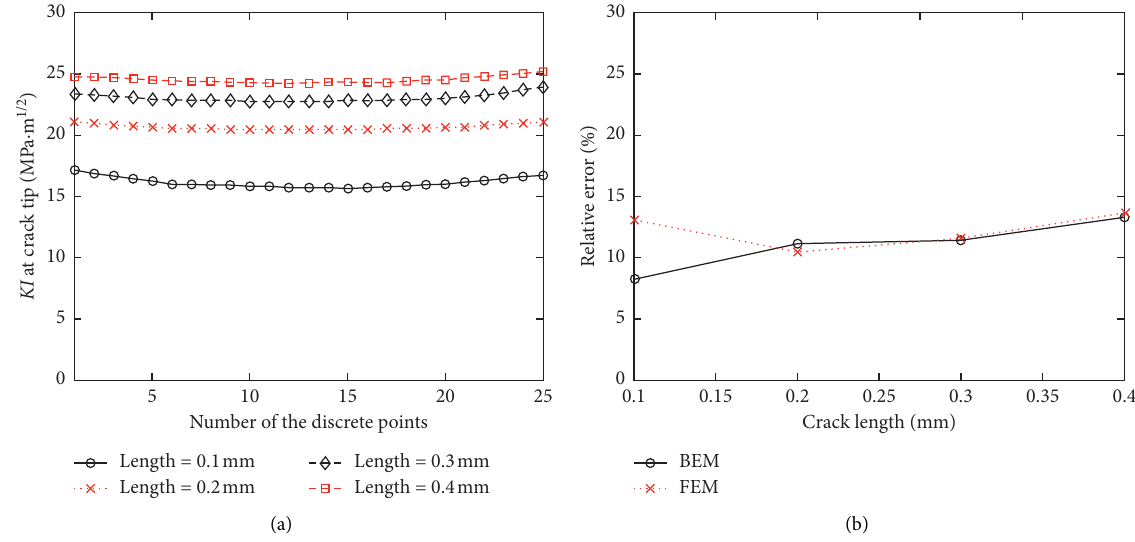
Figure 5: (a) KI value along the crack front. (b) Relative error comparisons between the FEM and the BEM.